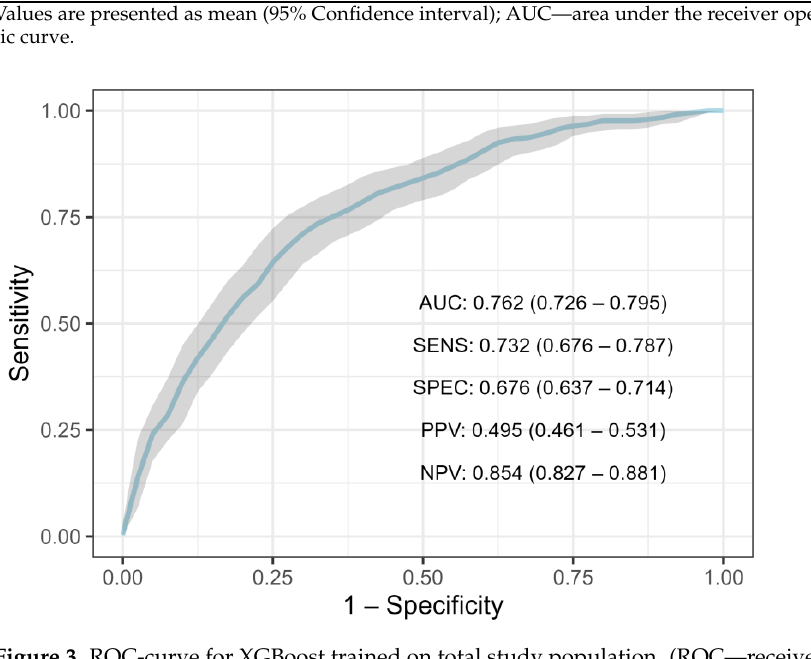
Figure 3. ROC-curve for XGBoost trained on total study population. (ROC—receiver operating char- acteristic curve, AUC—area under the curve, SENS—sensitivity, SPEC—specificity, PPV—positive predictive value, NPV—negative predictive value).